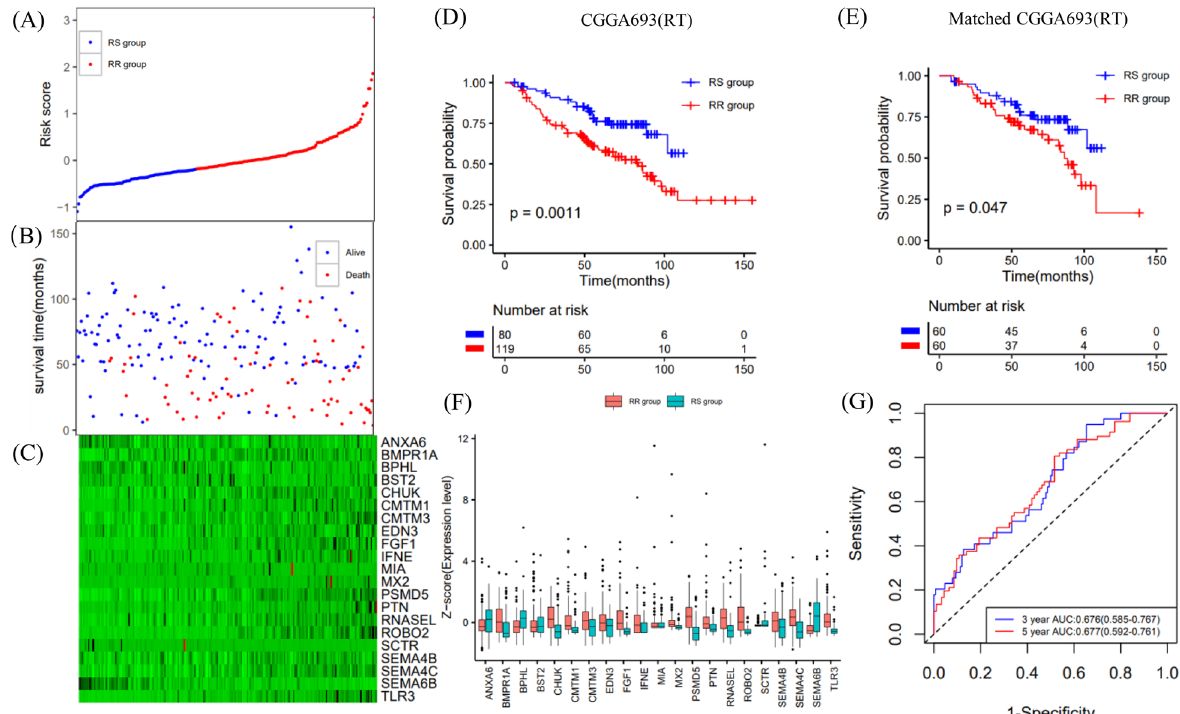
Figure 4. Validation of the OS prediction model based on 21 genes in the CGGA693 dataset. ( A , B ) The risk score, survival time of each sample. ( C ) Heatmap of 21 genes. ( D , E ) Survival curve of the RS group and RR group in radiotherapy patients in the unmatched and matched datasets. ( F ) The gene expression profile of the two groups of radiotherapy patients. ( G ) Time ‐ dependent ROC curve for OS.